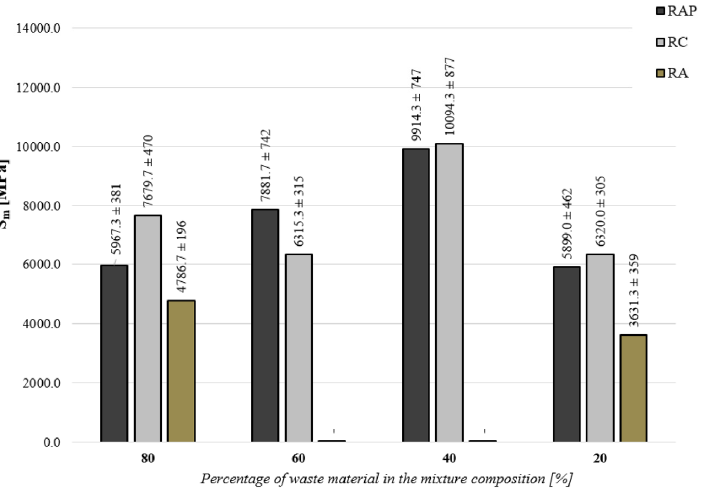
Figure 8. Stiffness modulus determined by indirect tension S m for cold recycled mix in terms of the quantity and type of recycled material.